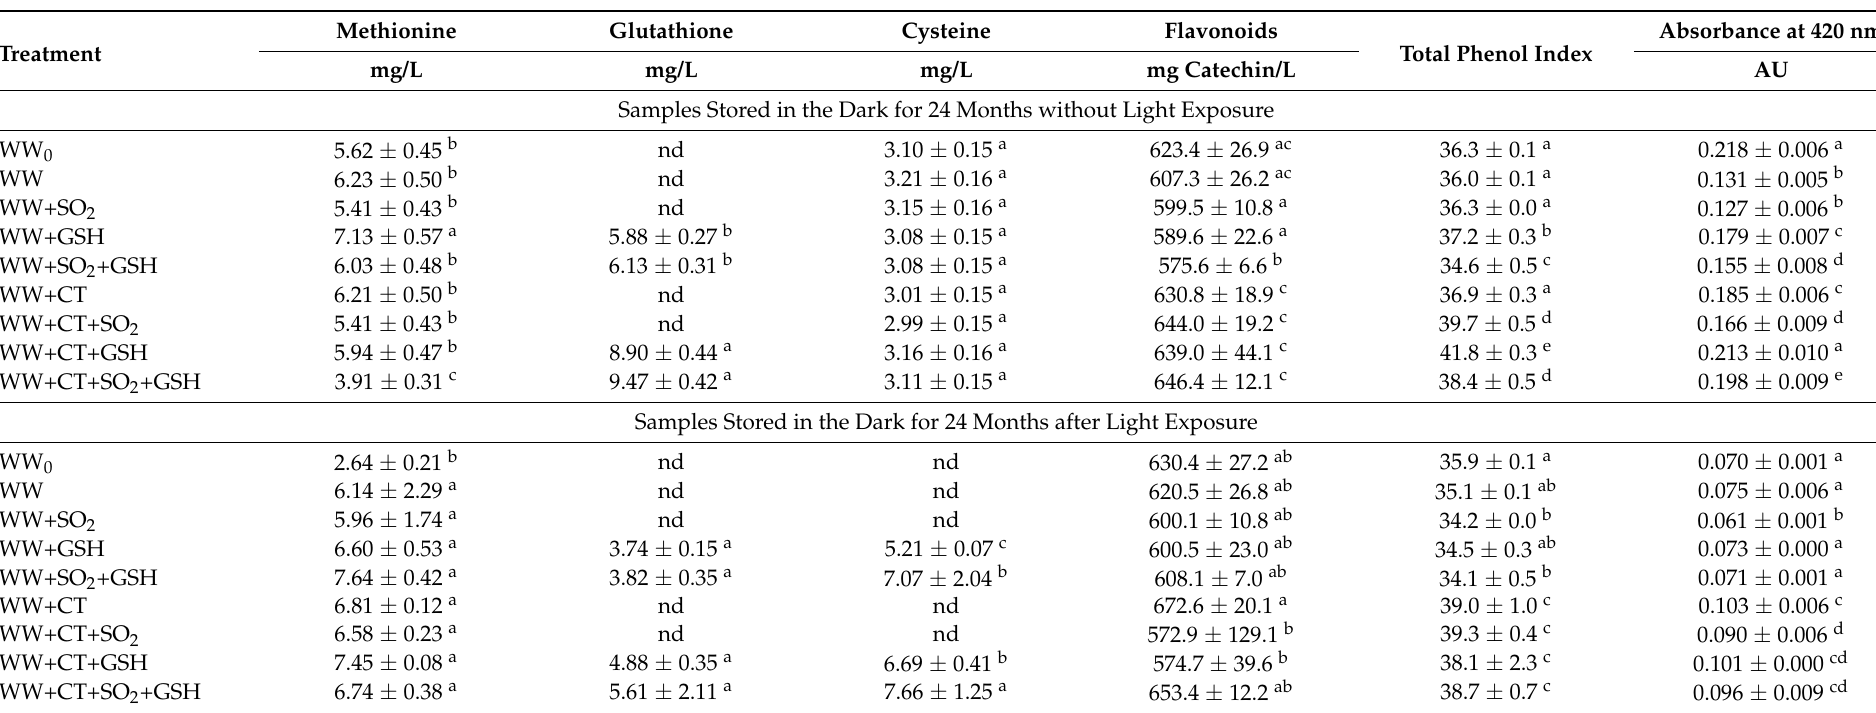
Table 3. Concentrations of methionine, glutathione, cysteine, flavonoids, total phenol index and absorbance values at 420 nm determined in white wine (WW)